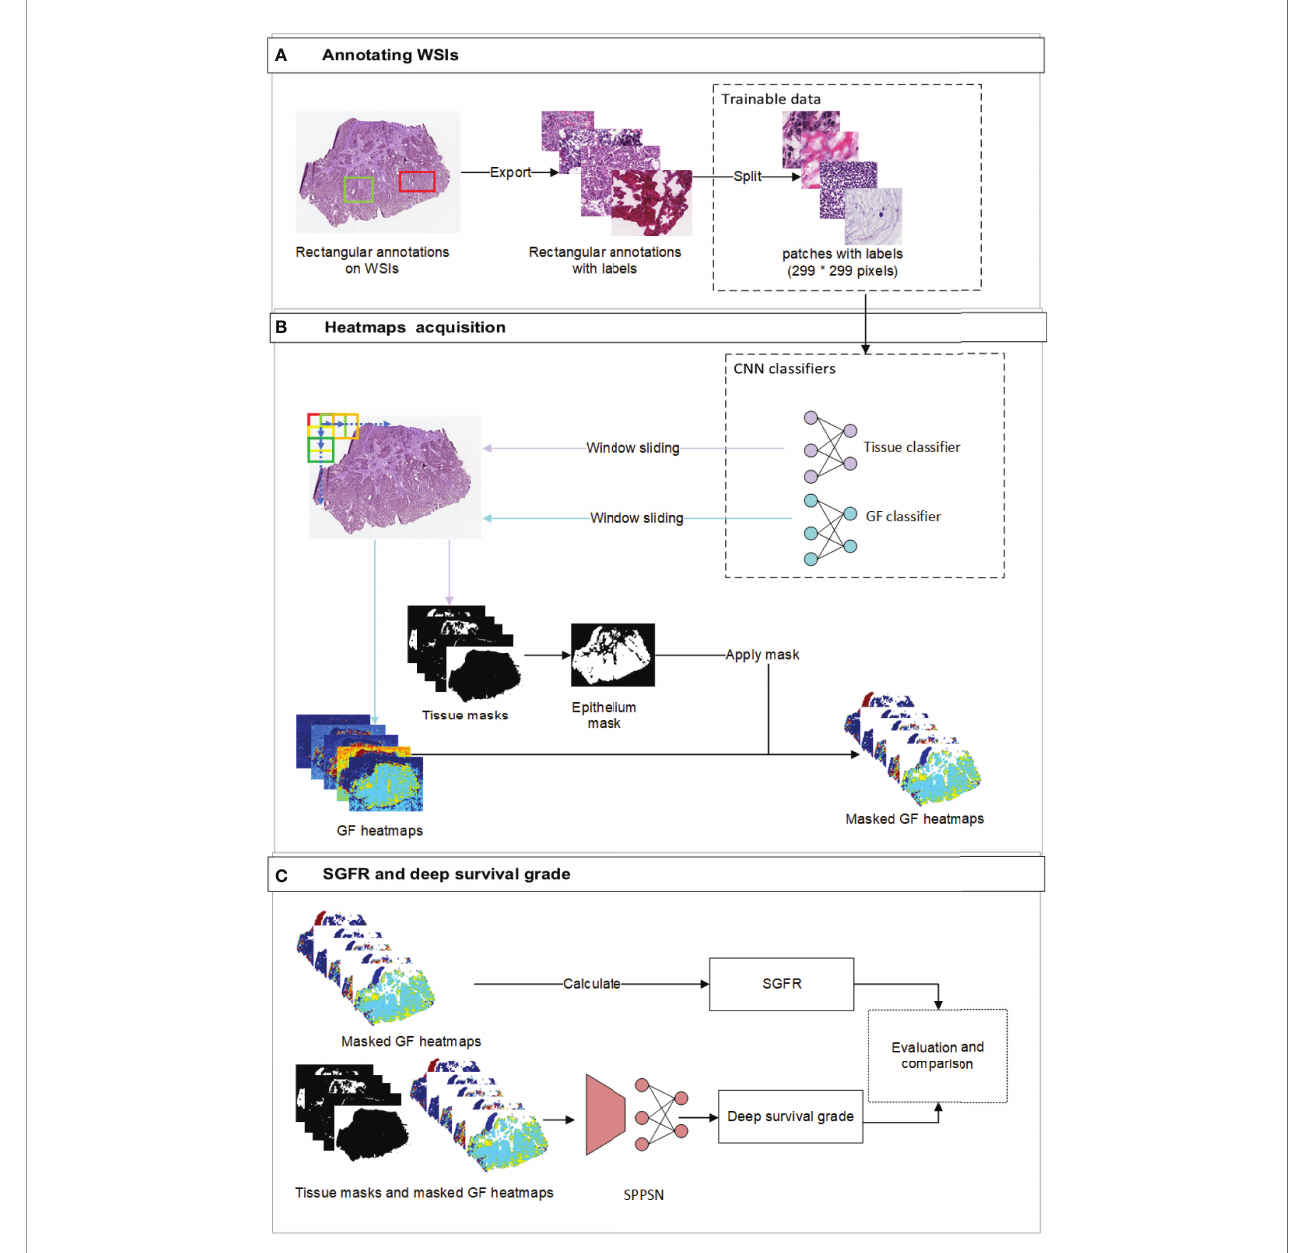
FIGURE 1 | The overview of the work fl ow. (A) The work fl ow of annotating labels and generating trainable patches. Our pathologists annotated rectangular annotations and related labels from original WSI. We then randomly sampled trainable patches from annotations and balanced the ratio of labels before training. (B) the work fl ow of developing gland formation and tissue category classi fi ers and generating spatial heatmaps. We used window sliding technique to generate masks of tissue categories and probability maps of tumor gland formation and other tissue types from classi fi ers. (C) The work fl ow of calculating SGFR and deep survival grade. The epithelium masks were speci fi cally applied to gland formation heatmaps, which were further used in both calculating SGFR and developing SPPSN. WSI, whole-slide image; SGFR, semi-quantitative gland formation ratio; SPPSN, spatial pyramid pooling survival